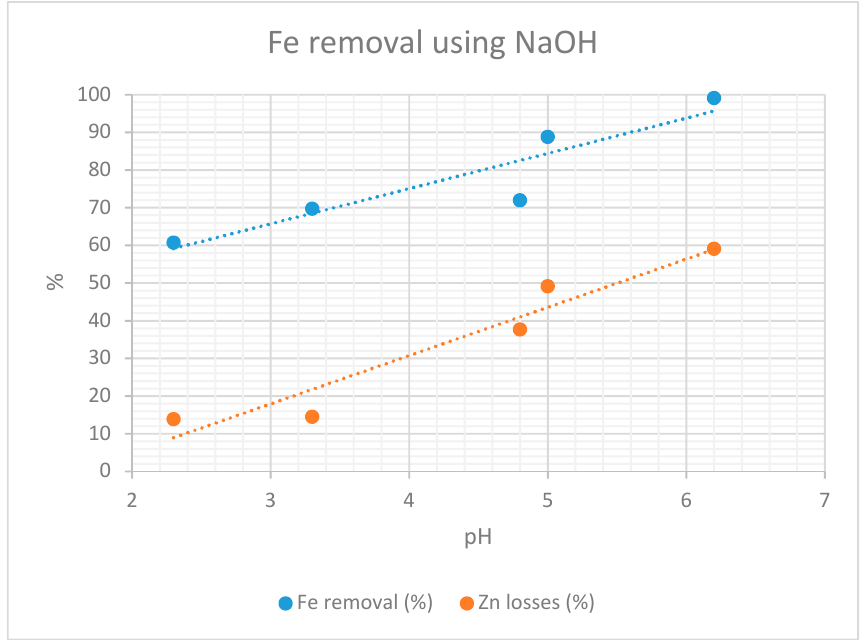
Figure 10. Exploratory test results using NaOH.